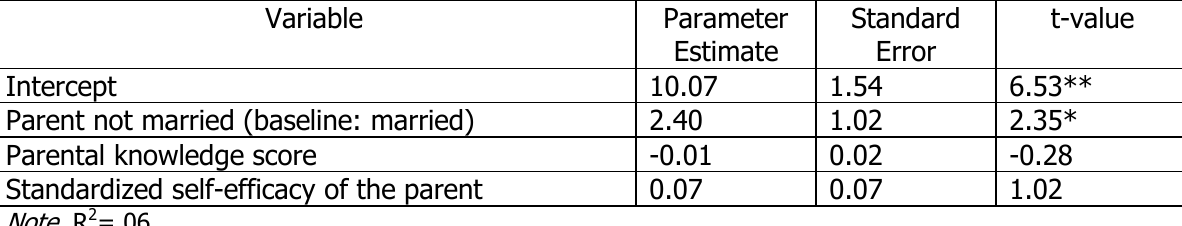
Summary of Regression Analysis on General Communication Discrepancy